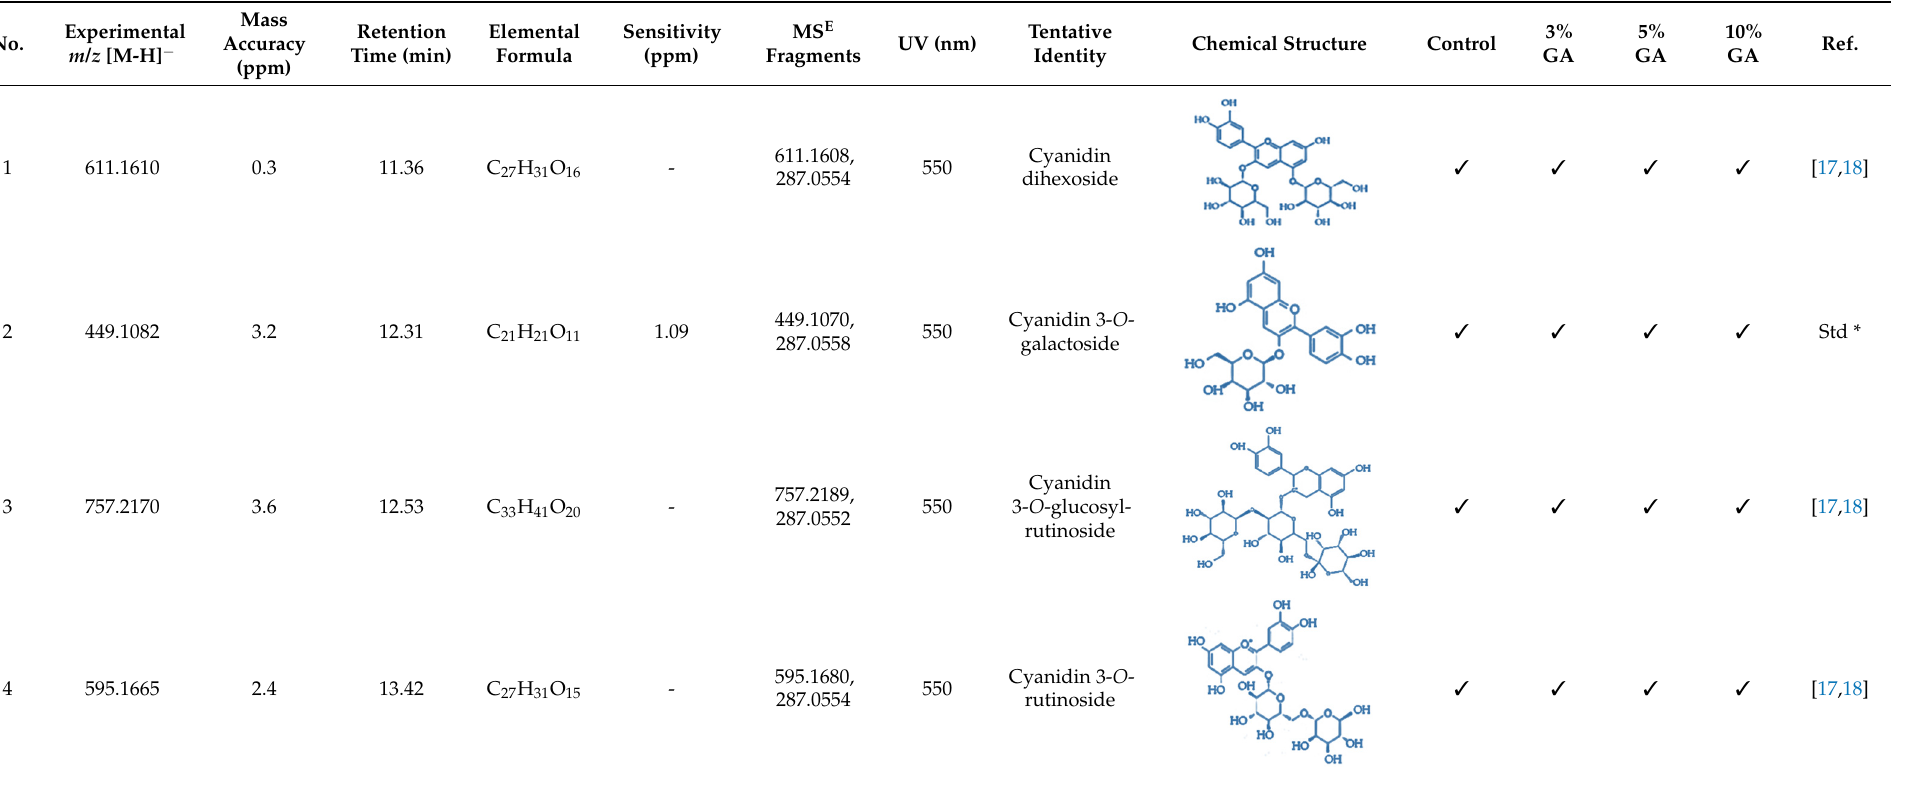
detected [M-H] − ion, elemental composition, MS E fragments and UV absorbance.